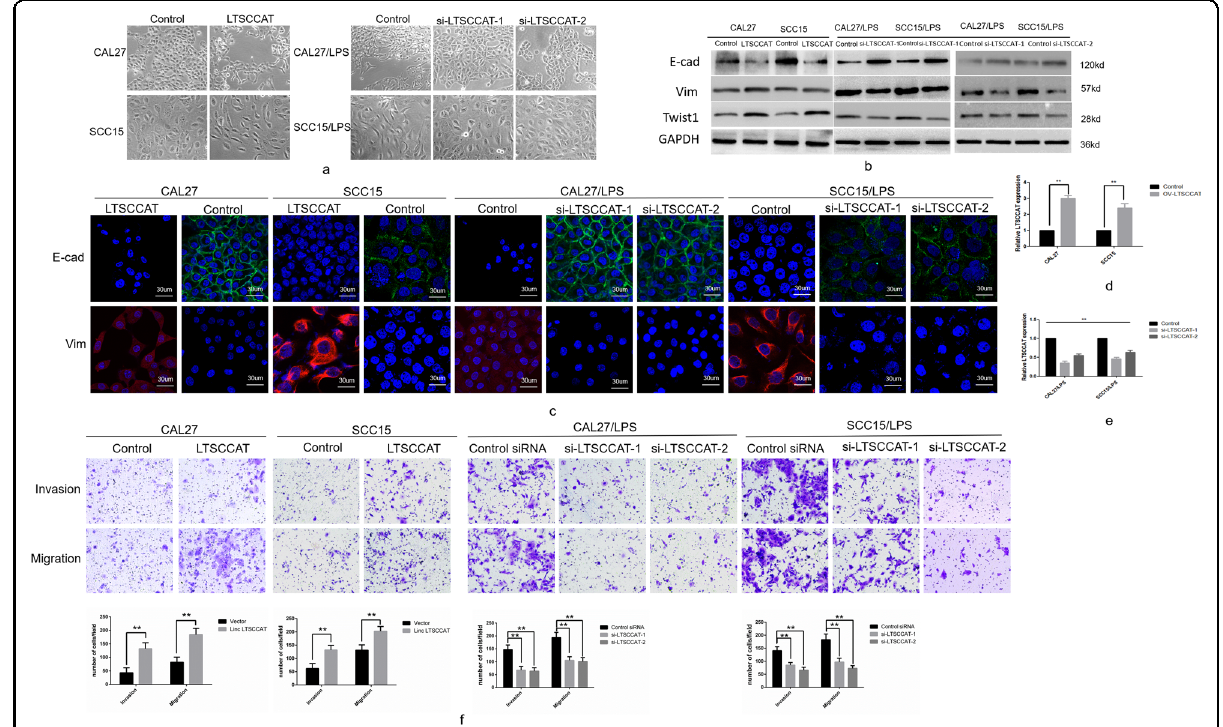
Fig. 3 LTSCCAT promotes invasion and migration of tongue squamous cell carcinoma. a Left: after upregulation of LTSCCAT in CAL27 and SCC15 cells, cells transitioned from an epithelial morphology to interstitial morphology. Right: after knockdown of LTSCCAT expression with two siRNAs in CAL27/LPS and SCC15/LPS, cells gradually transitioned from an interstitial morphology to epithelial morphology. (×200). b Western blot analyses showed that after overexpression of LTSCCAT in CAL27 and SCC15 cells, E-cadherin decreased and vimentin and Twist1 increased. After knockdown of LTSCCAT with two siRNAs in CAL27/LPS and SCC15/LPS cells, E-cadherin increased and vimentin and Twist1 decreased. c Immuno fl uorescence results showed that E-cadherin was downregulated and vimentin was upregulated in CAL27 and SCC15 cells after overexpression of LTSCCAT, whereas E-cadherin was upregulated and vimentin was downregulated after knockdown of LTSCCAT with two siRNAs in CAL27/LPS and SCC15/LPS cells. d After overexpression of LTSCCAT in CAL27 and SCC15, the expression level of LTSCCAT was upregulated compared with control cells. e After knockdown of LTSCCAT with two siRNAs in CAL27/LPS and SCC15/LPS cells, the expression level of LTSCCAT was downregulated compared with control cells. f Transwell invasion and migration assays demonstrated that the invasive and migratory ability of CAL27 and SCC15 cells was increased after overexpression of LTSCCAT, and the invasion and migration of CAL27/LPS and SCC15/LPS cells decreased after LTSCCAT knockdown. Error bars represent the mean±S.D. from three independent experiments. (** P <